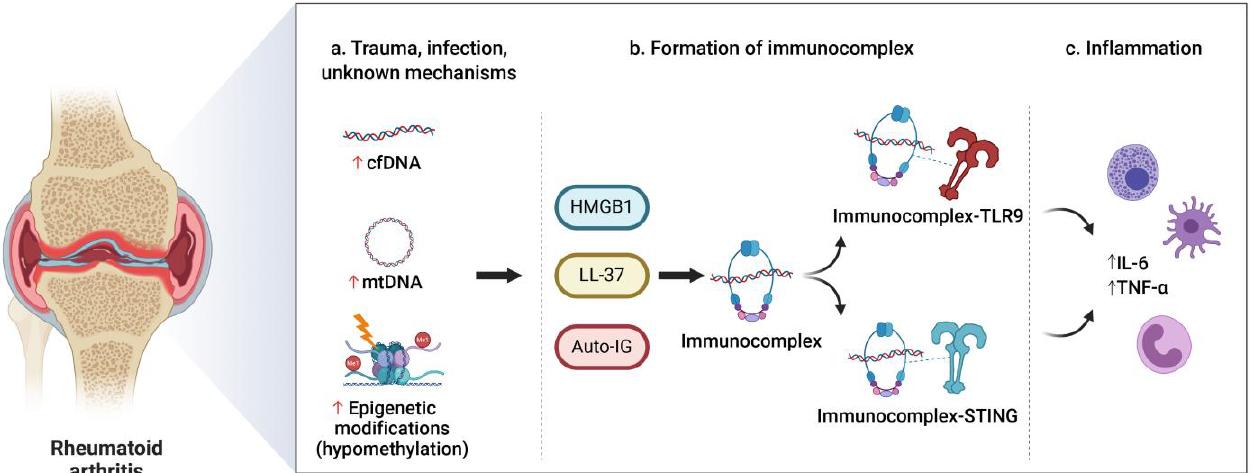
Figure 2. Potential mechanisms involving synovial fluid circulating-free DNA and the development of rheumatoid arthritis (RA). Release of cfDNA could increase in conditions including trauma, infections, or other mechanisms that we do not know ( a ). In addition, synovial fluid cfDNA seems to be enriched with specific hypomethylated CpG motif-rich sequences, with capacity to induce severe inflammatory responses independently. CfDNA and mtDNA can bind with LL-37, HMGB1, auto-Ig, and other proteins to form immunocomplexes that can be recognized by pattern recognition receptors (TLR-9 or STING) ( b ). This would facilitate the induction of cytokine overexpression, TNF- α and IL-6, that are critical for RA pathogenesis ( c ). Abbreviations: cfDNA, circulating-free DNA; HMGB1, high mobility group box chromosomal protein 1; IG, immunoglobulins; IL-6, interleukin 6; LL-37, human cathelicidin LL-37; mtDNA, mitochondrial DNA; STING, stimulator of interferon genes; TLR-9, toll-like receptor 9; TNF- α , tumor necrosis factor alpha.